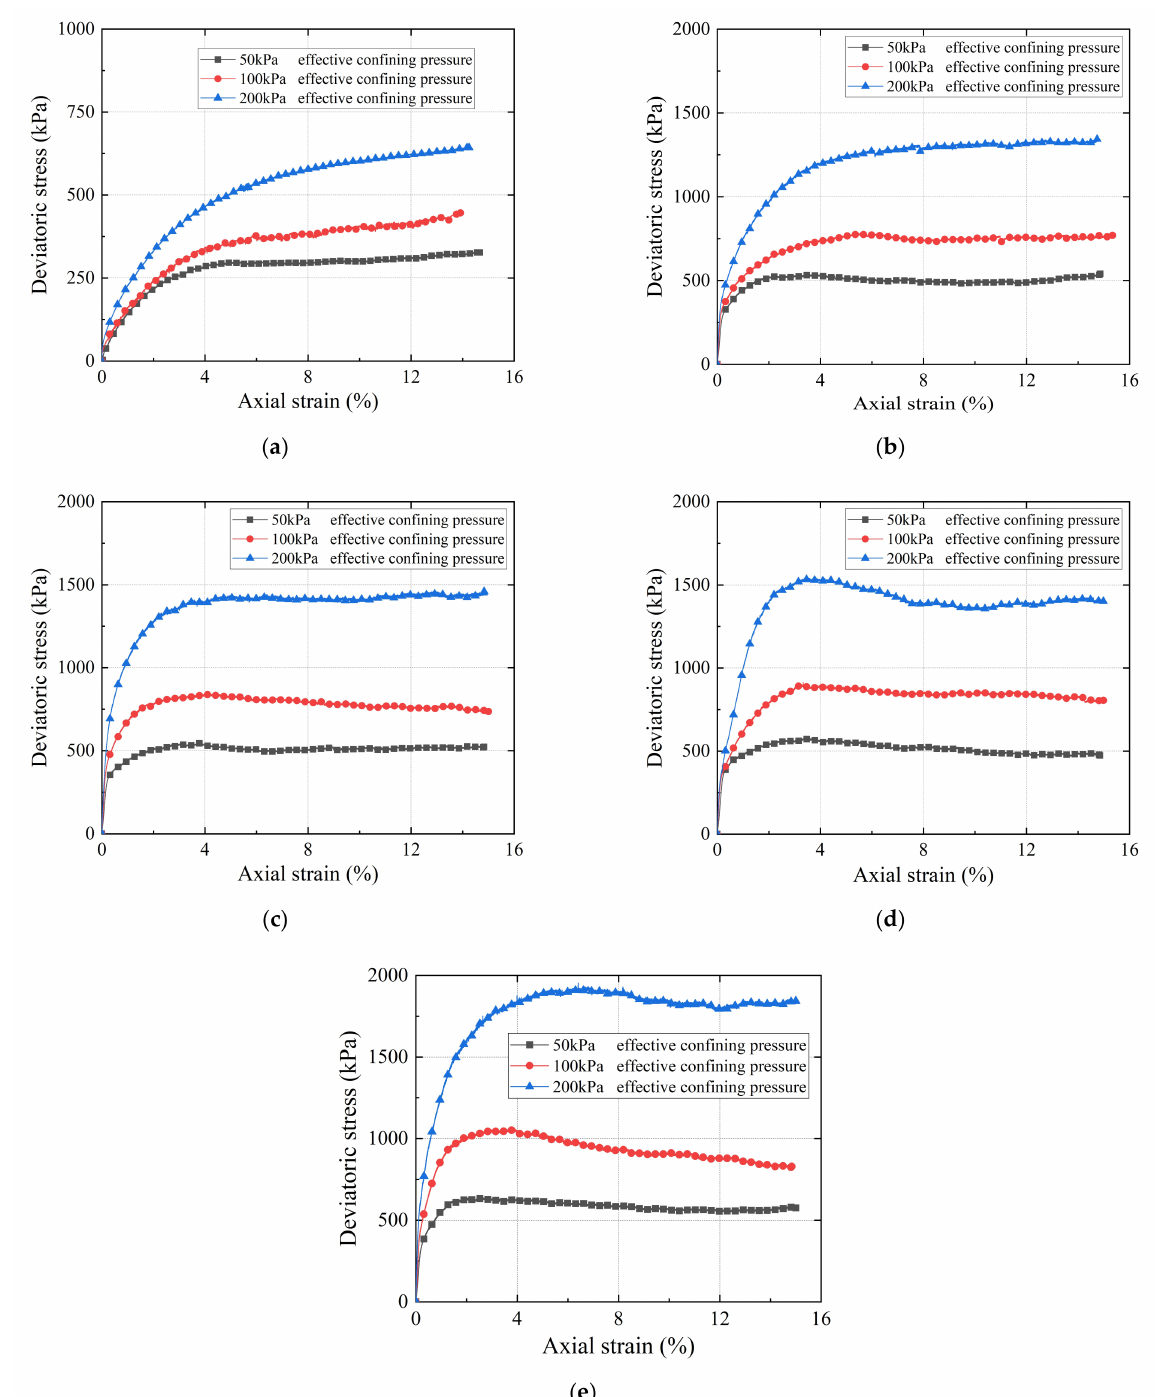
Figure 9. Deviator stress versus axial strain curves determined from the consolidated drained monotonic triaxial compression tests for the recycled BDW aggregates with different gradations: ( a ) G/S = 1.0; ( b ) G/S = 1.6; ( c ) G/S = 1.8; ( d ) G/S = 2.0; and ( e ) G/S =